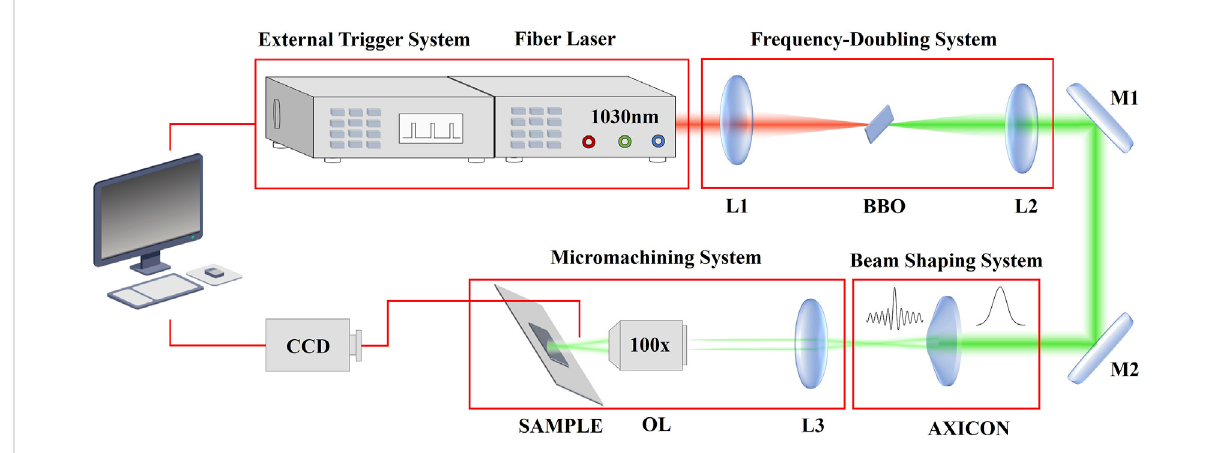
FIGURE 1 The experimental setup for the preparation of nanostructures on silica. The experimental setup consists of four parts: light source, frequency doubling, beam shaping, and processing stage. L, lens; M, mirror; OL, objective